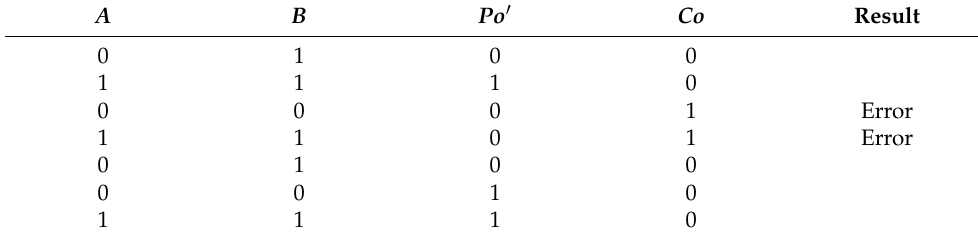
Table 3. Truth table of odd parity